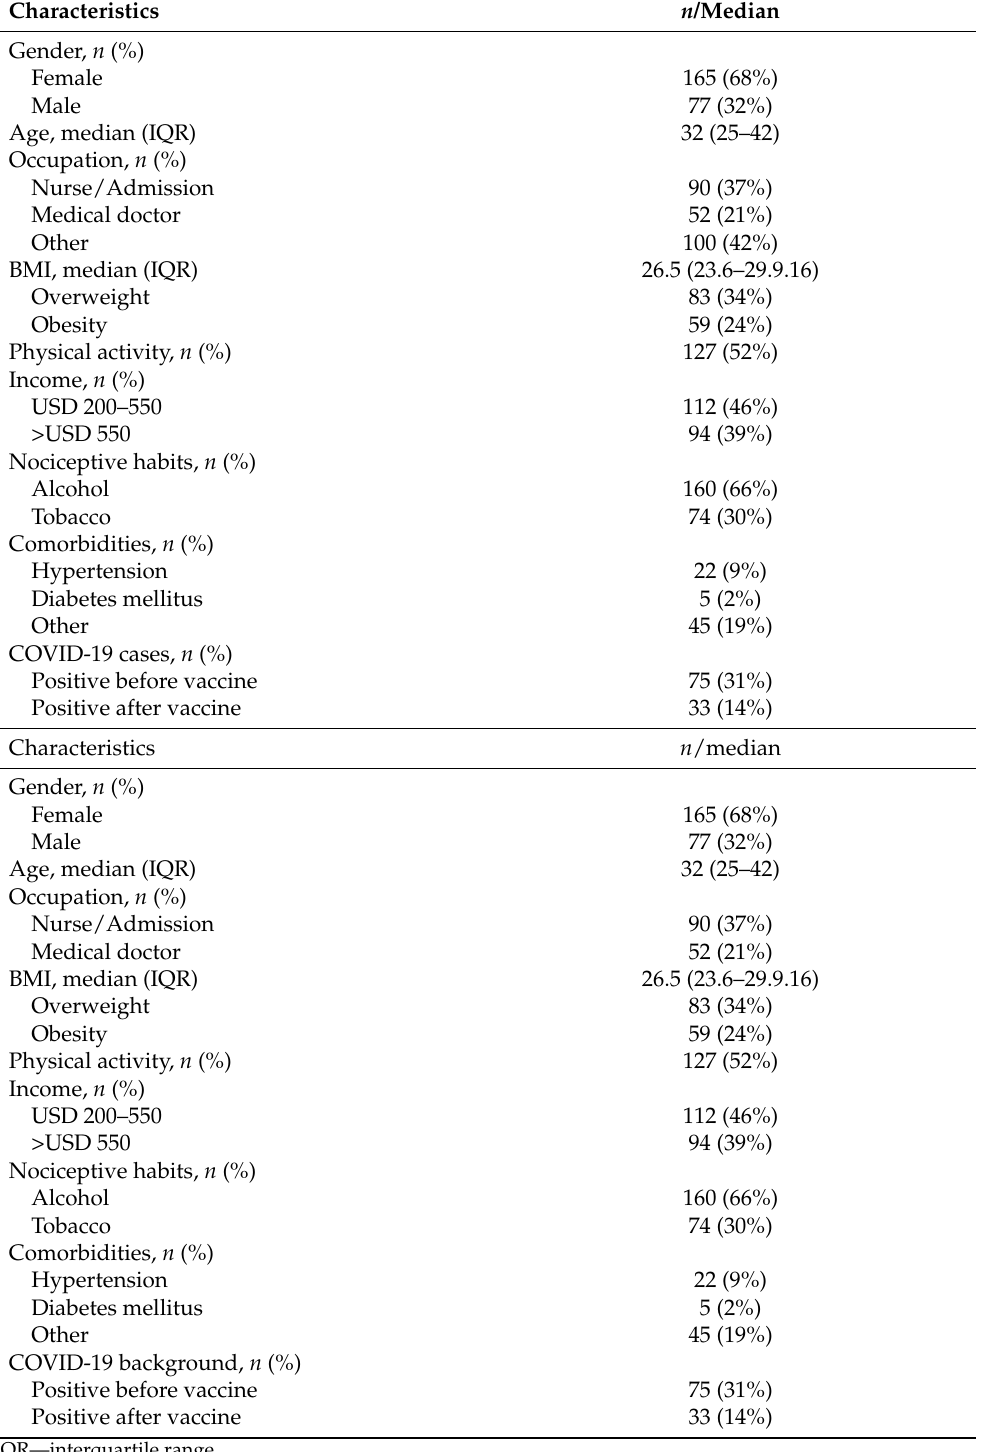
Table 1. Clinical and demographic characteristics of the